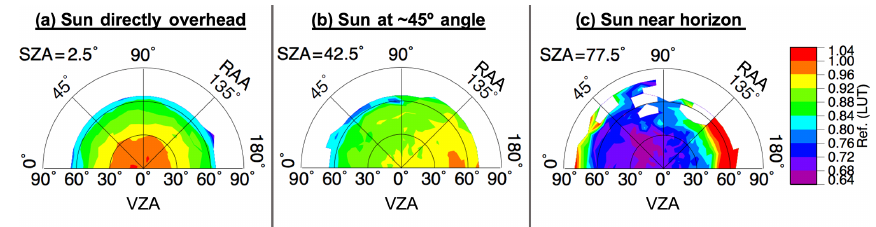
Figure 3. Illustration of LUT for average anvil reflectance as a function of VZA, SZA, and RAA, based on December 2016 through November 2017 GOES-13, GOES-15, and Himawari-8 retrievals. Polar plots are shown for the (a) 2.5, (b) 42.5, and (c) 77.5 ◦ SZA bins ( ± 2 . 5 ◦ ). The radial coordinates of each plot indicate the change in VZA, demarcated into 18 bins with 5 ◦ bin increments from 2.5 to 87.5 ◦ ( ± 2 . 5 ◦ ). The polar coordinates of each plot indicate the change in RAA, demarcated into 18 bins with 10 ◦ bin increments from 5 to 175 ◦ ( ± 5 ◦ ), where 0 ◦ RAA is the backscattering angle. Gaps at certain bin indices indicate a lack of anvil sampling for that angular configuration.